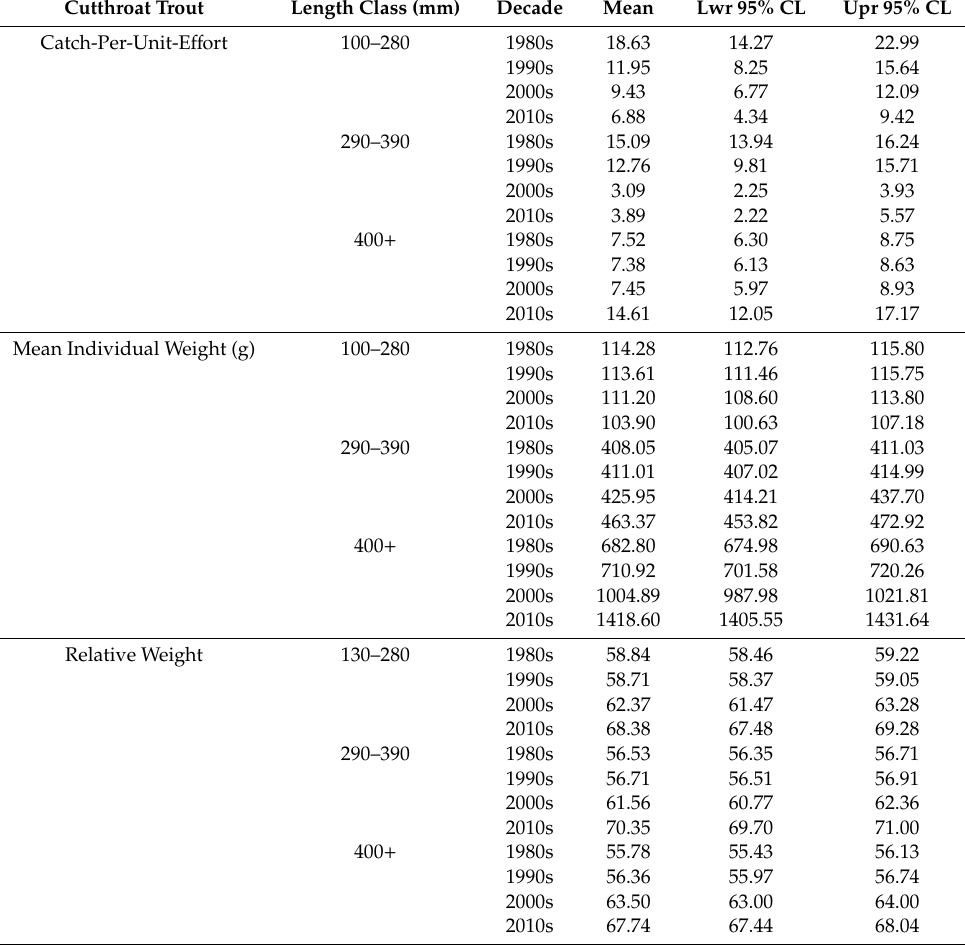
Table A7. Mean catch-per-unit-e ff ort (100-m net night), individual weight (g), and relative weight with lower (Lwr) and upper (Upr) 95% confidence limits (CL) of each of three length groups (mm) of cutthroat trout from annual gillnetting assessments during each decade (1980–2019) on Yellowstone Lake.